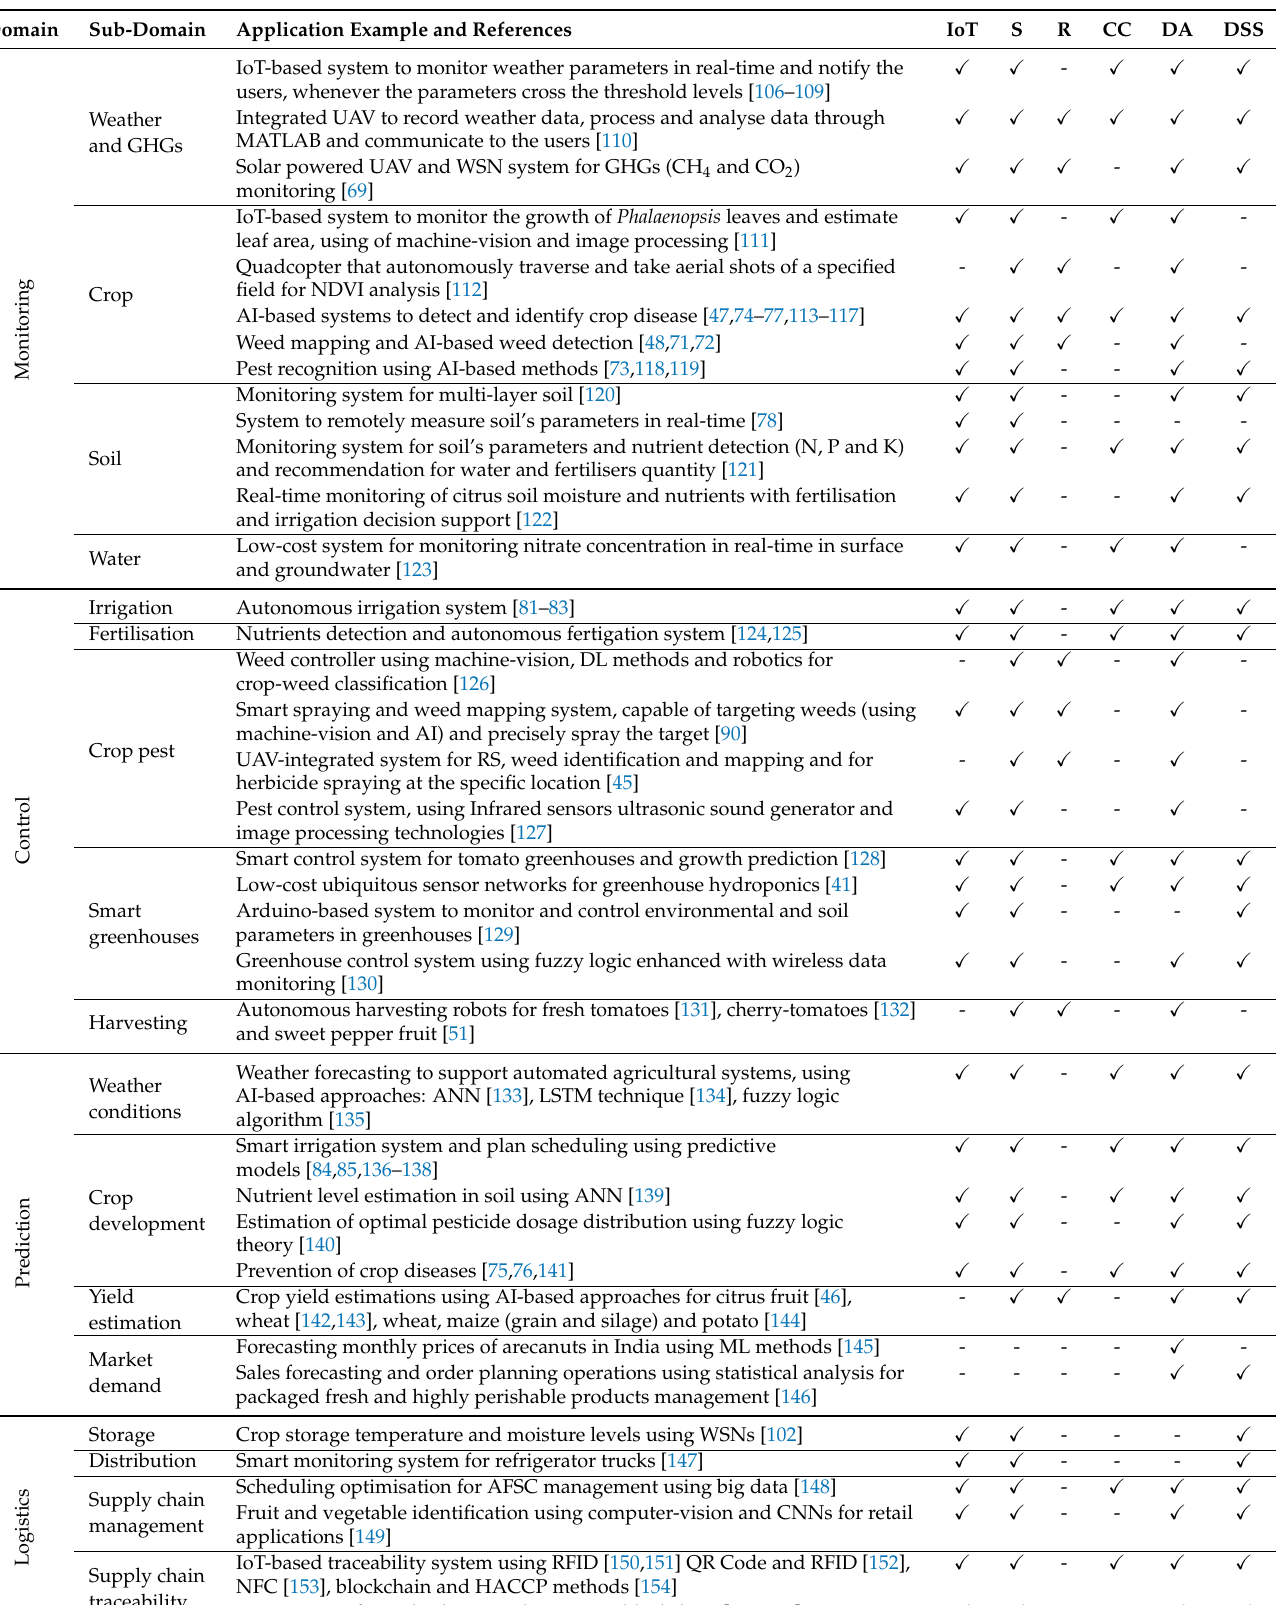
Table 5. Agriculture 4.0 applications per domain and specific sub-domain, along with their associated enabling technologies (IoT, Internet of Things; S, sensors; R, robotics; CC, cloud computing; DA, data analytics; DSS, decision support system). These technologies are marked if they are addressed in at least one of the references identified in the respective application